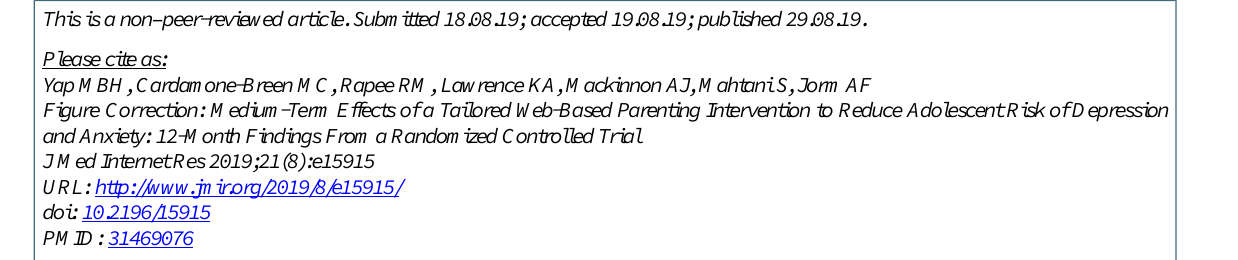
Figure Correction: Medium-Term Effects of a Tailored Web-Based Parenting Intervention to Reduce Adolescent Risk of Depression and Anxiety: 12-Month Findings From a Randomized Controlled